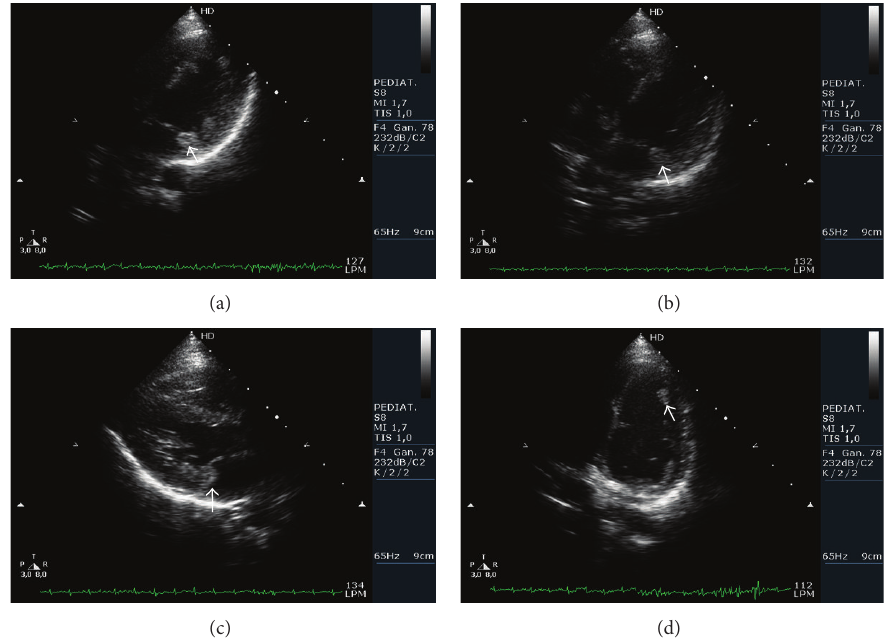
Figure 2: Royalty rhabdomyomas after 28-month followup. Note the disappearance of intramural rhabdomyomas and persistence of rhabdomyoma mainly located in the anterior leaflet of the mitral valve. (a) Four-chamber view with intracavitary mass in mitral valve (arrow). Disappearance of intraparietal mass in lateral wall of left atrium viewed in Figure 1(b). (b) Four-chamber doppler-colour view of intracavitary mass in tricuspid valve smaller than before, one intracavitary mass in mitral valve and disappearance of intraparietal mass in lateral wall of left atrium (arrow). (c) Longitudinal long axis of left ventricule with intracavitary mass on mitral valve (arrow). (d) Four-chamber view of intraparietal tumour in left ventricule apex smaller than before